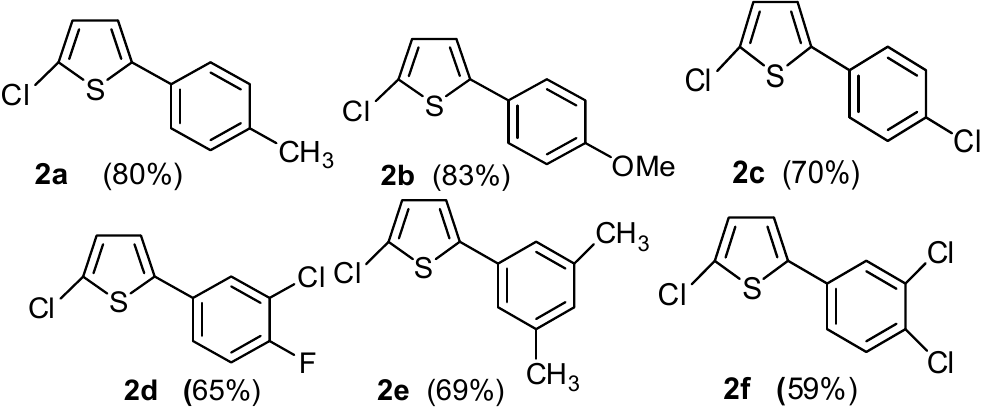
Figure 2. Synthesis of compounds 3a – f .